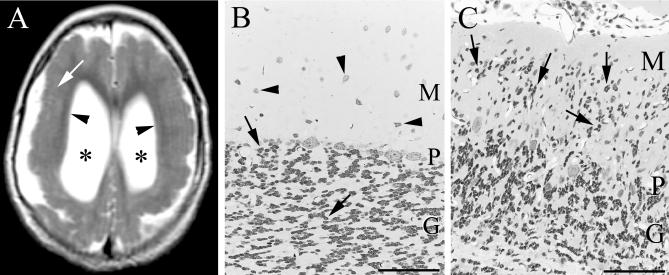
LCMV Infection Disrupts Neuronal Migration in the Developing Brain of Humans and Rats(A) MRI scan of a 3-y-old child with congenital LCMV infection. The MRI scan demonstrates microencephaly and a deficit of white matter (arrowheads) with a compensatory enlargement of the lateral ventricles (asterisks). There is also a diminished number of cortical sulci and an abnormally smooth cortical surface (white arrow). This is strongly suggestive of pachygyria, a developmental defect due to abnormal neuronal migration.(B and C) are 2-μm-thick sections through the cerebellar cortex of uninfected control (B) and LCMV-infected (C) rats.(B) Normal cerebellar cortex from a control (uninfected) adult rat demonstrating the trilaminar cytoarchitecture of the cortex, which consists of the molecular layer (M), Purkinje cell layer (P), and granule cell layer (G). Within the molecular layer, a few stellate cells and basket cells (arrowheads) are normally present. In contrast, granule cells (arrows) have migrated through the molecular layer to the granule cell layer. Granule cells no longer reside in the molecular layer in the normal cerebellum.(C) Cerebellar cortex from an adult rat infected during early postnatal life with LCMV. Many granule cells (arrows) remain abnormally placed within the molecular layer. As a result of LCMV infection, these neurons have failed to migrate properly to their normal location within the granule cell layer and remain permanently ectopic within the molecular layer.Magnification bars represent 100 um in (B and C).